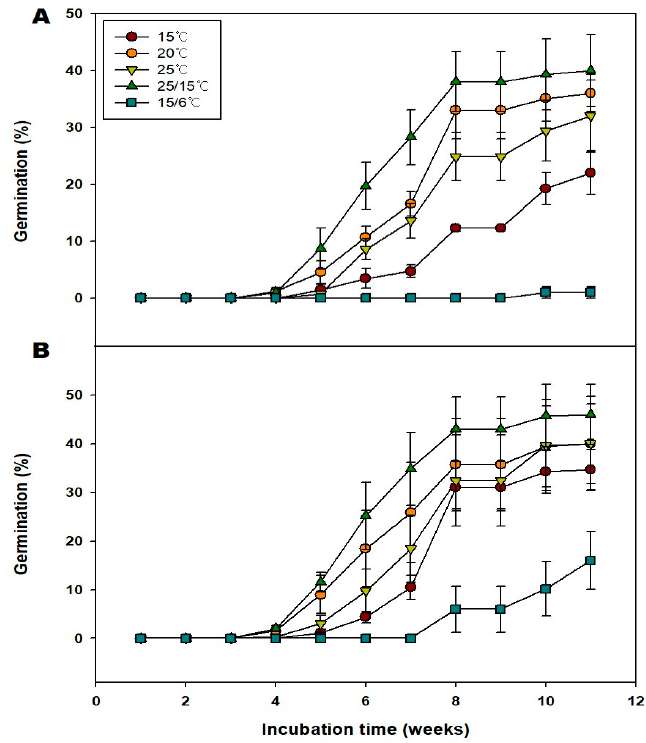
Figure 5. Effects of the 250 and 500 ppm GA 3 treatments with alternate and constant temperatures on the germination of the Vaccinium oldhamii Miq. seeds. ( A ); 250 ppm GA 3 , ( B ); 500 ppm GA 3 . Seeds collected in 2021 were used for this study. Vertical bars indicate standard error (n =